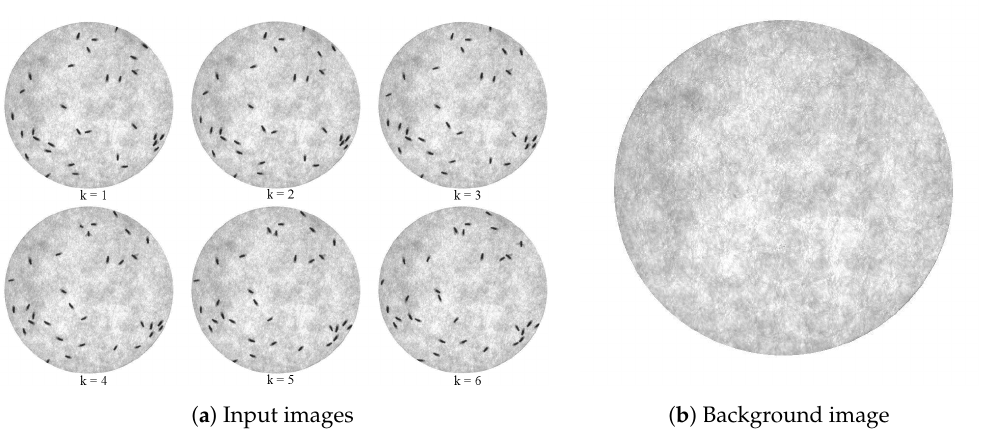
Figure 1. ( a ) Input images and ( b ) extracted background image. The input image contains six consecutive frames of a circular arena with 32 Drosophila as the black ovals inside. The background image was generated by using a number of frames from the same video file as the input